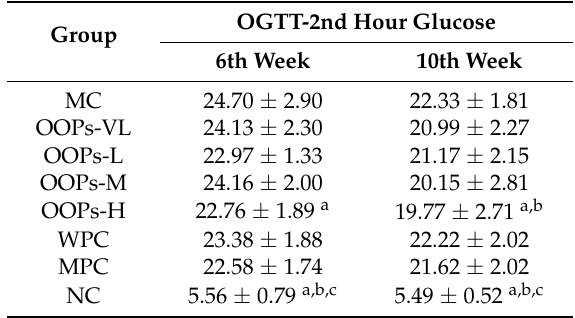
Table 4. Effect of OOPs treatment on the OGTT-2nd hour